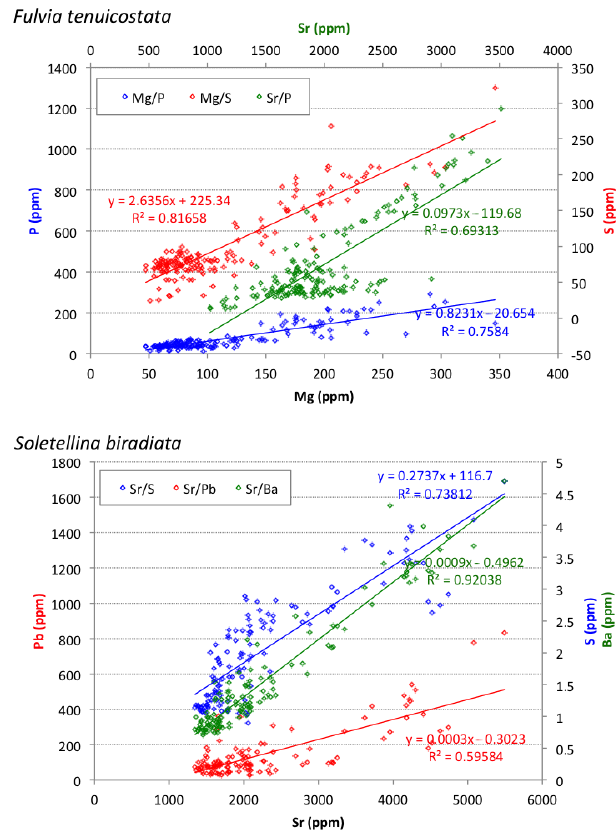
Figure 12. Graphs showing the significant linear correlations of the LA-ICP-MS measurements for F. tenuicostata (Mg / P, Mg / S and Sr / P) and S. biradiata (Sr / S, Sr / Pb and Sr /